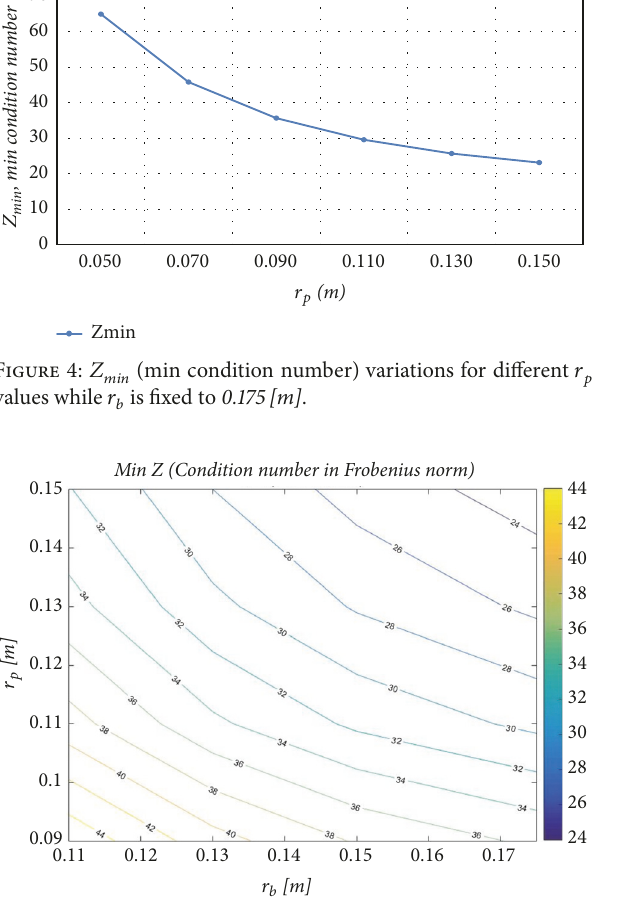
Figure 5: 𝑍 𝑚𝑖𝑛 with respect to 𝑟 𝑝 and 𝑟 𝑏 in predefined reachable workspace.